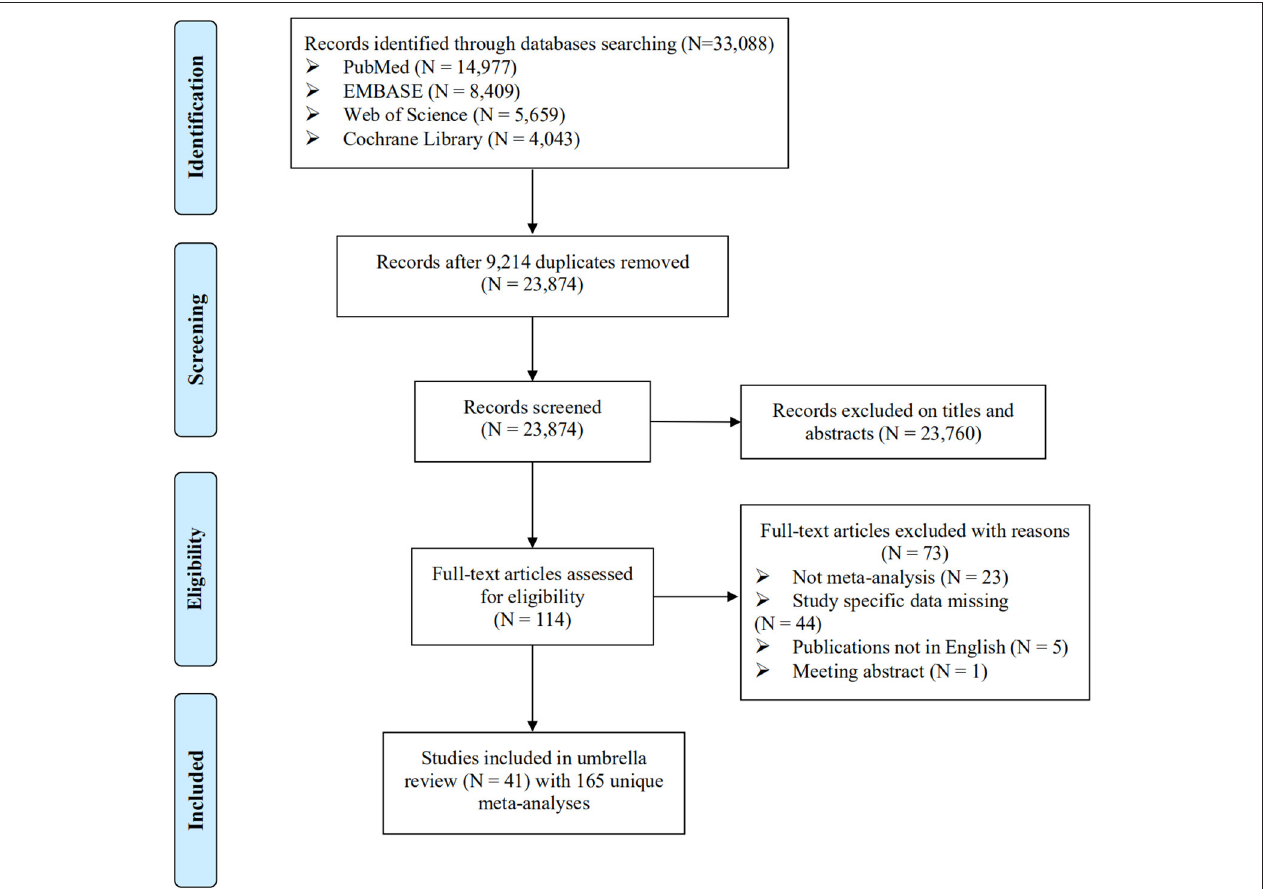
FIGURE 1 | Flowchart of selection of studies for inclusion in umbrella review on environmental factors and CHD.